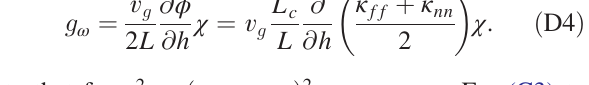
FIG. 9. Predicted optomechanical coupling coefficients for ¼ 7 μ m, as in the experiment, varying fiber height when (a) L c ¼ 21 μ m, for a nanobeam of length L ¼ L and (b) L . c c Also shown is the coupling rate between the nanobeam and ð h Þ . the forward propagating fiber taper waveguide mode γ e ¼ 7 μ m and (c) Corresponding transmission functions for L c ¼ 21 μ L c